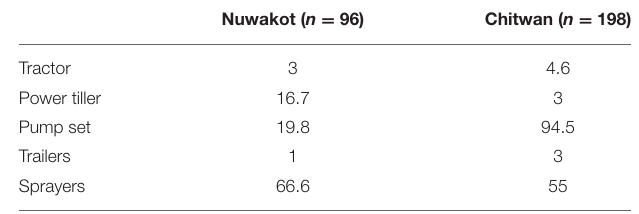
TABLE 6 | Farm equipment ownership in the study areas, Nepal (% households